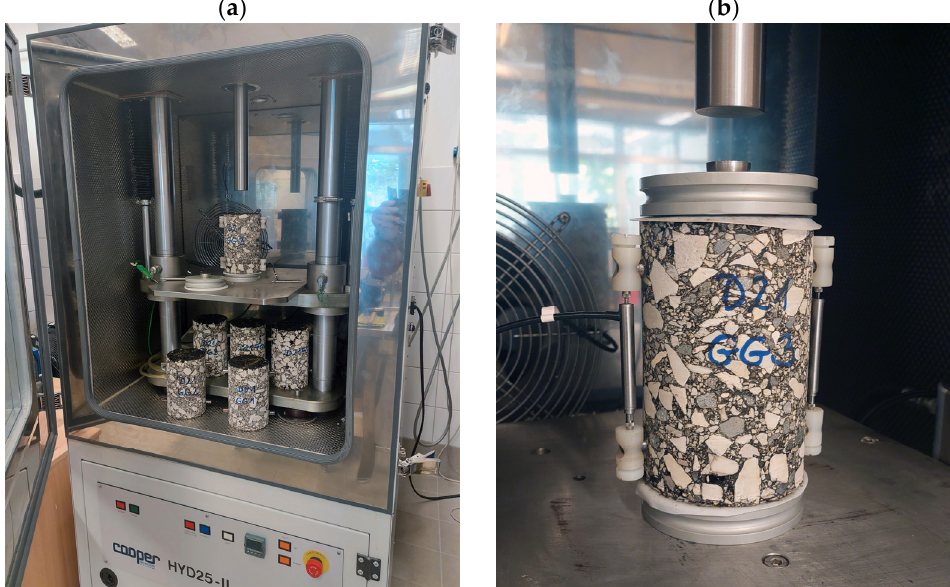
Figure 2. Complex modulus analysis in the study: the dynamic analyser device (HYD25-II) ( a ); the specimen prepared for testing the complex modulus ( b ).